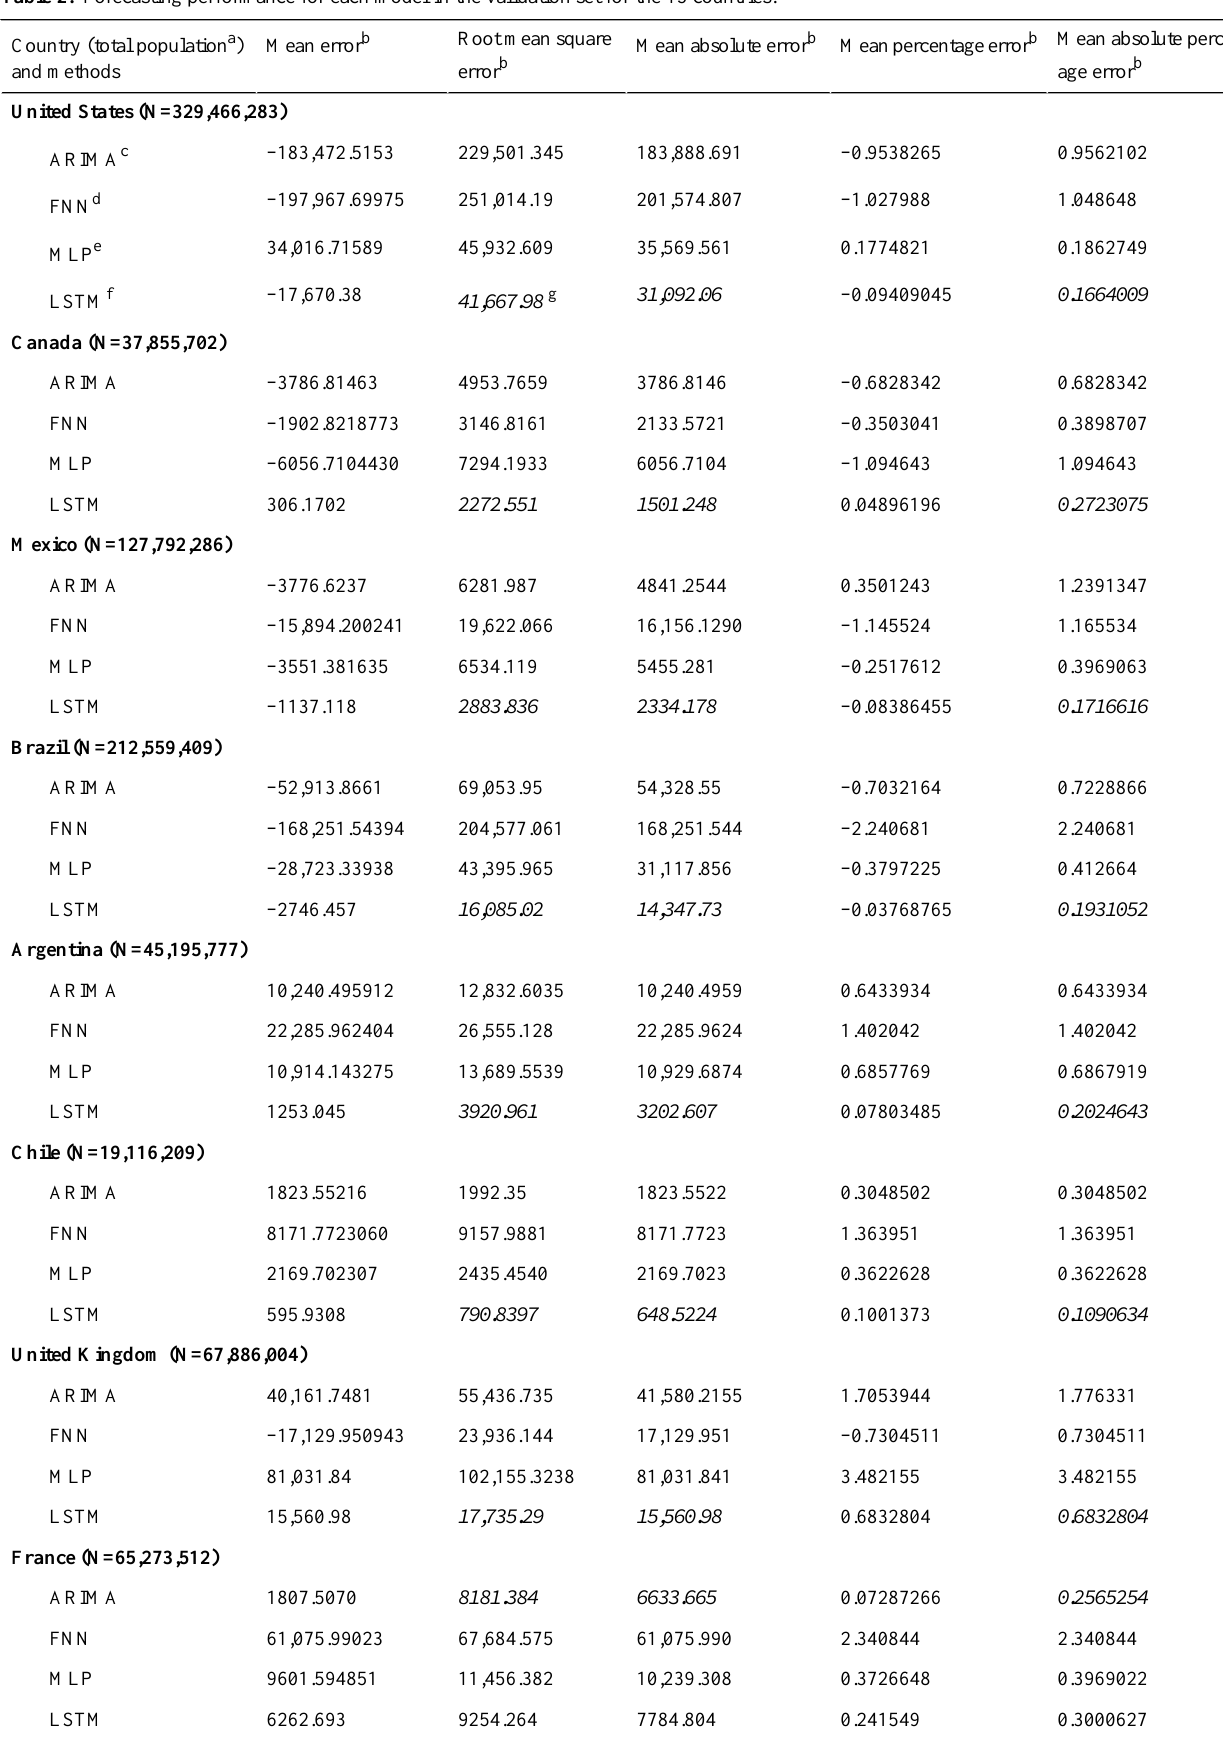
Table 2. Forecasting performance for each model in the validation set for the 15 countries.